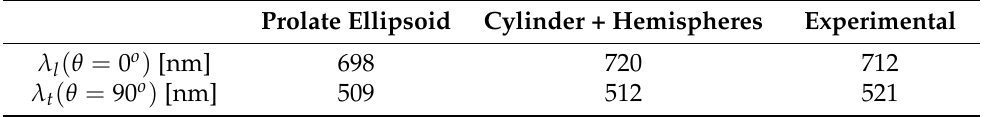
Table 1. Resonant wavelengths for the two simulated geometries and observed